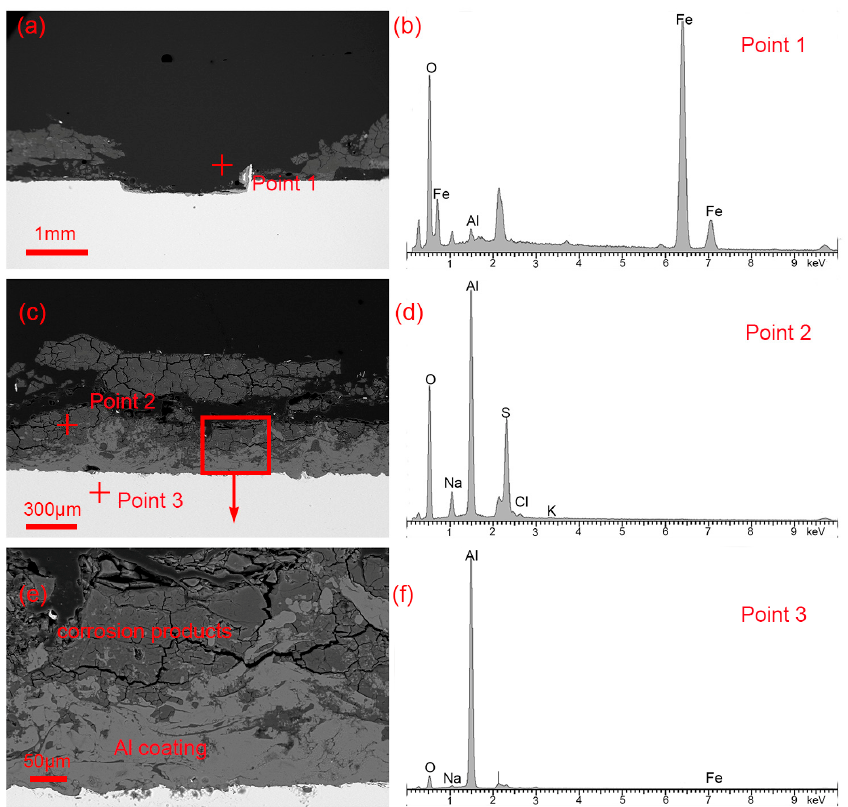
Figure 3. ( a , c , e ) SEM images of coating samples with scribed lines after 3 months of salt spray test. Some EDS patterns obtained from the region of interest are shown in ( b , d , f ).